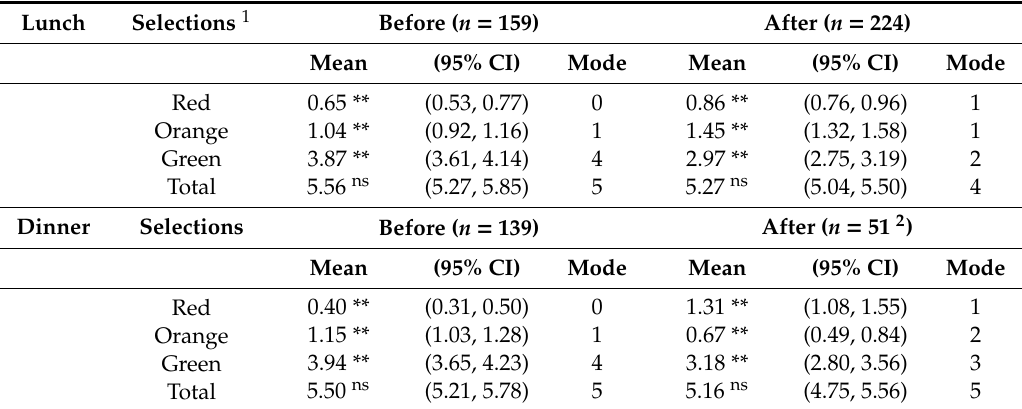
Table 2. Number of bu ff et selections, per plate, before and after, assessed by plate photography.